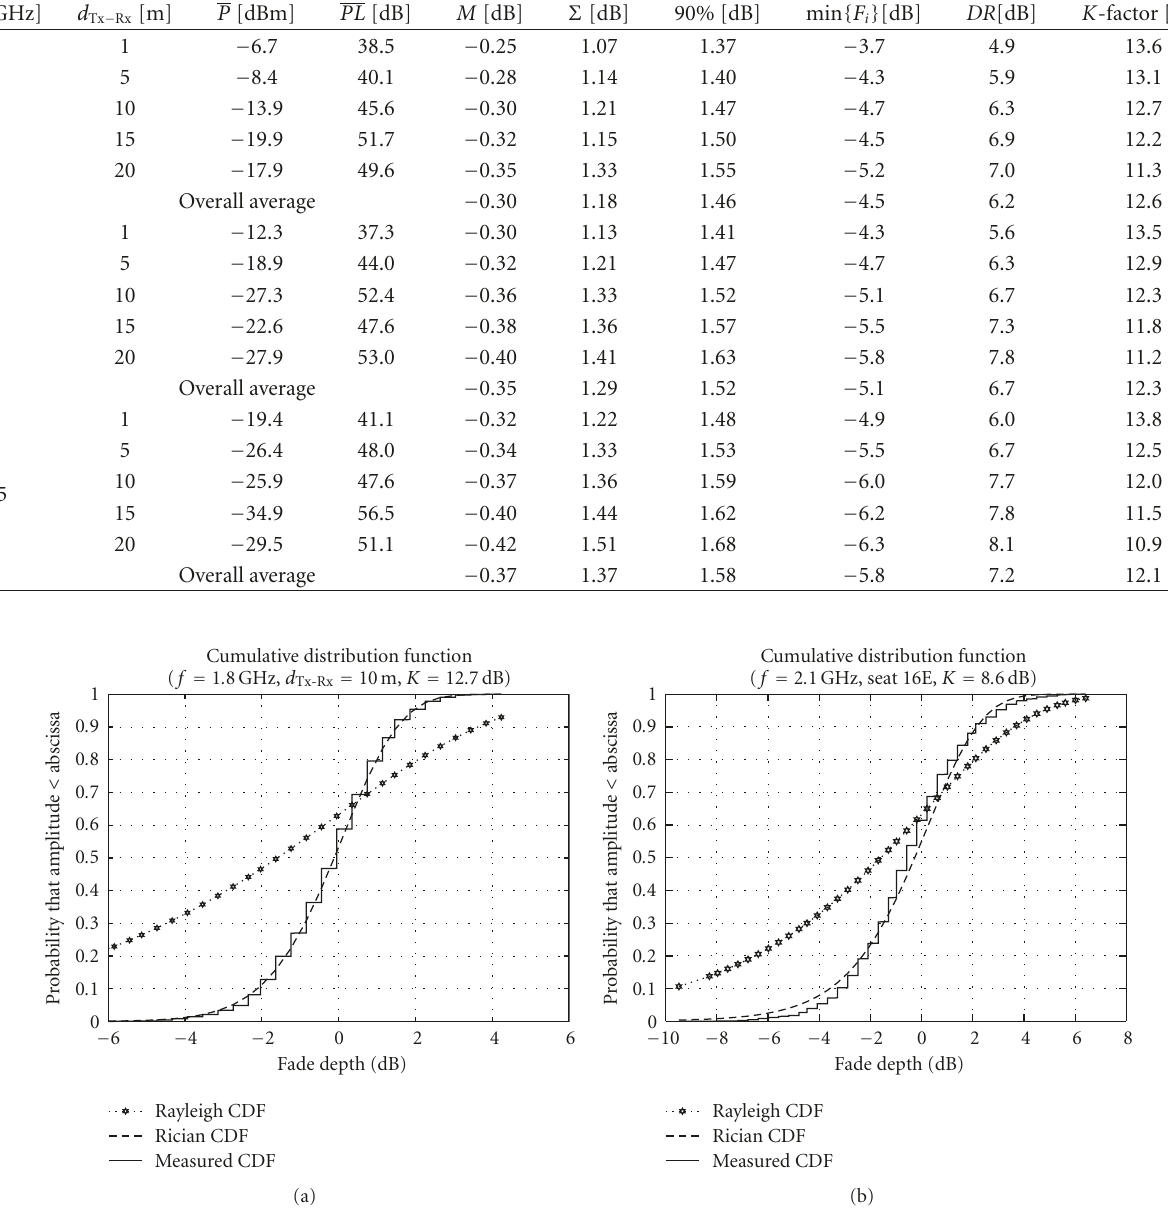
Cumulative distribution functions (CDFs) for the